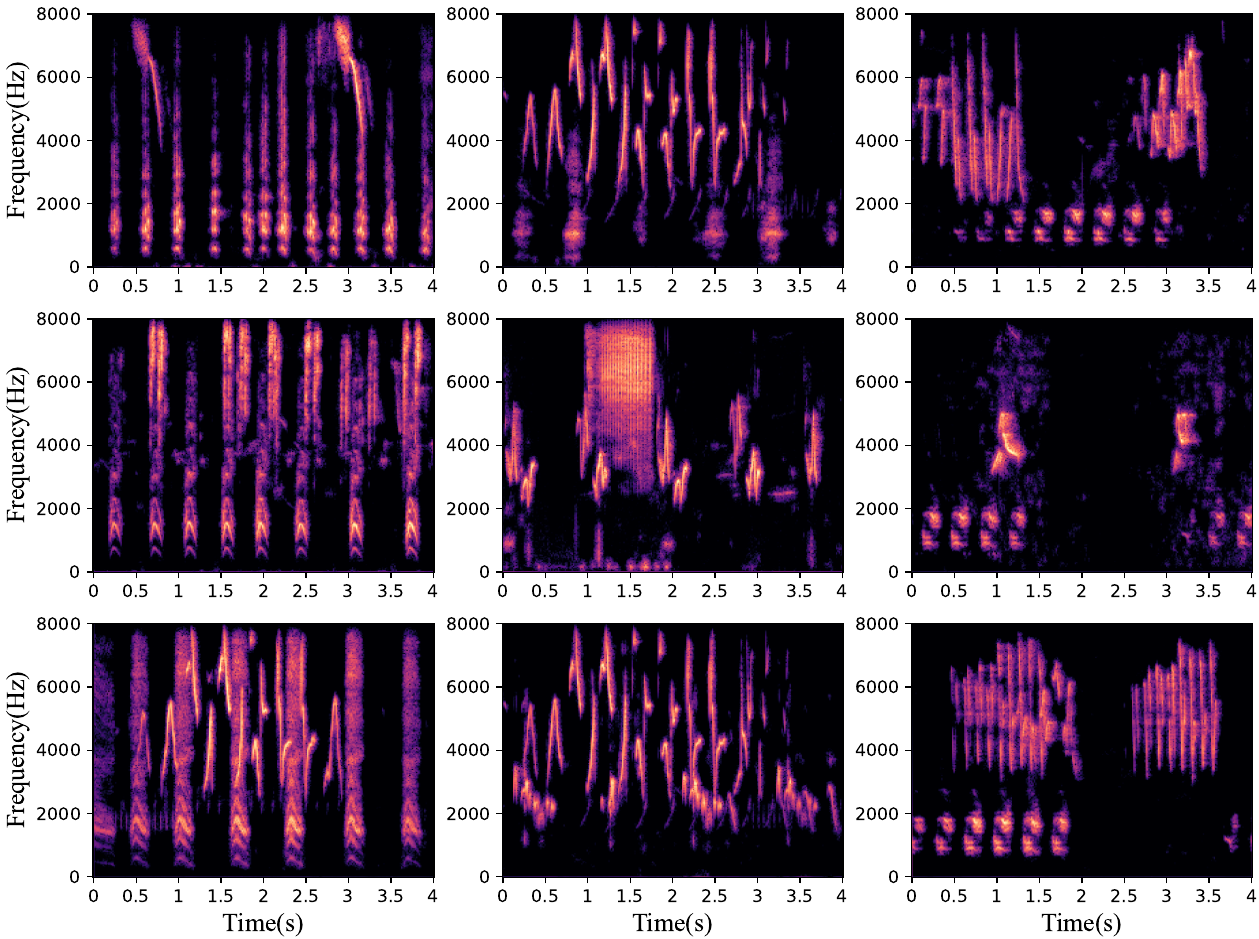
Figure 3. Some samples in the mixed species bird sound